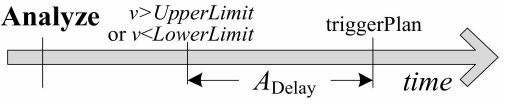
Figure 4. Triggering-Delay Time A Delay for Analyze.